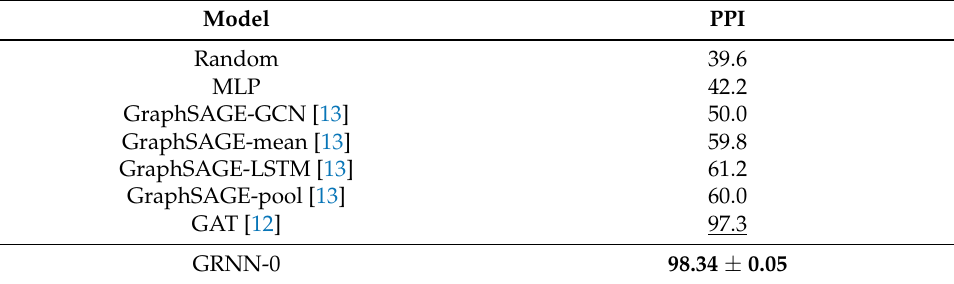
Table 3. Summary of micro-averaged F1 scores (%) on